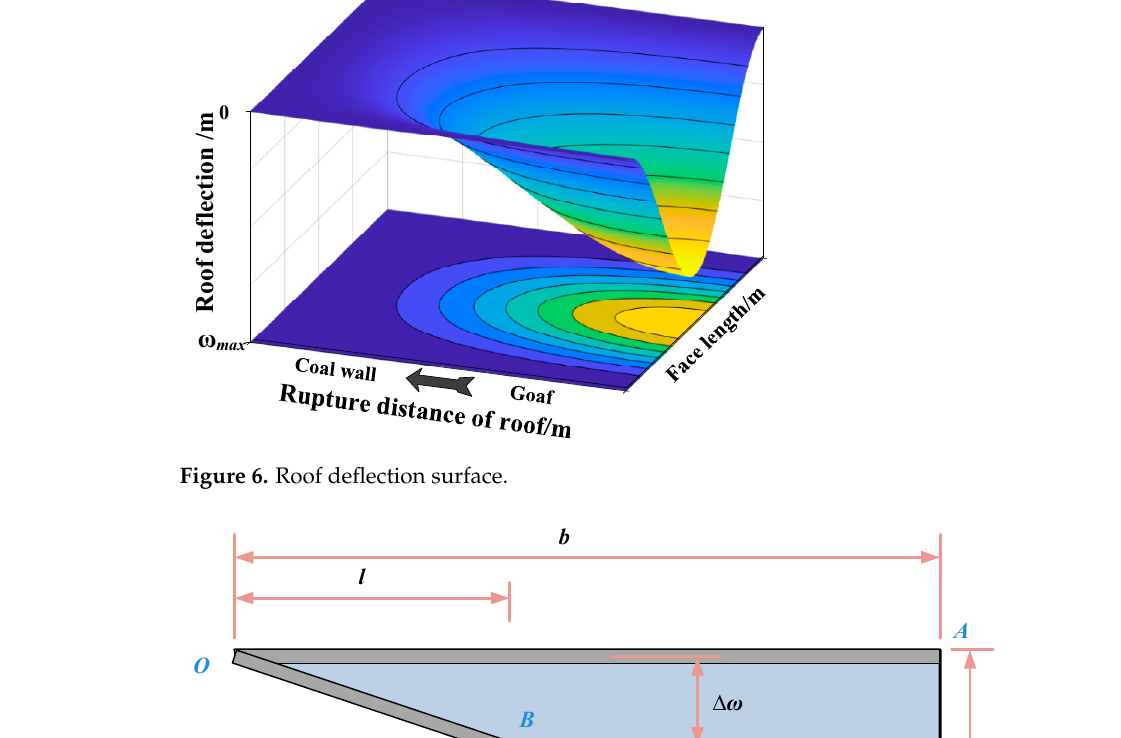
Figure 6. Roof deflection surface.